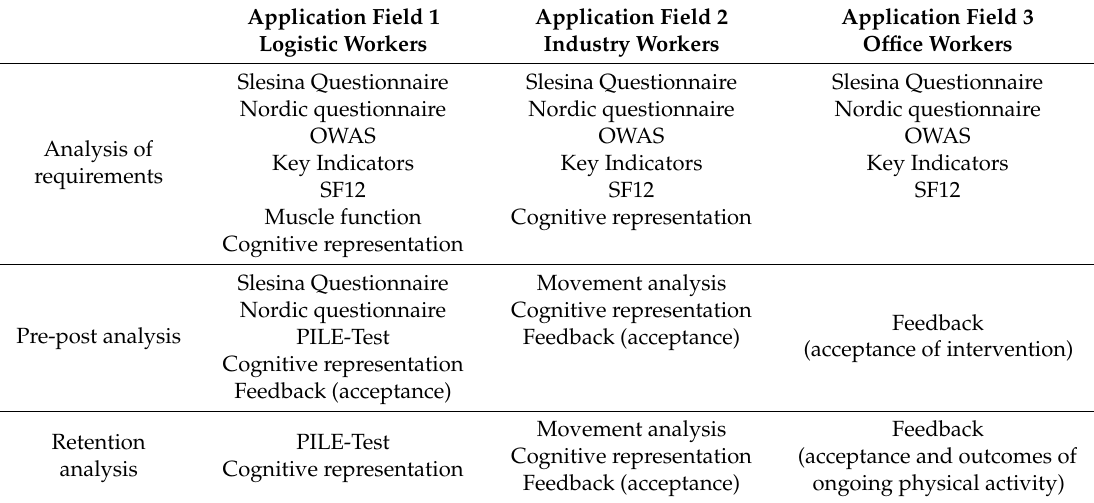
Table 2. Methods used in the different application